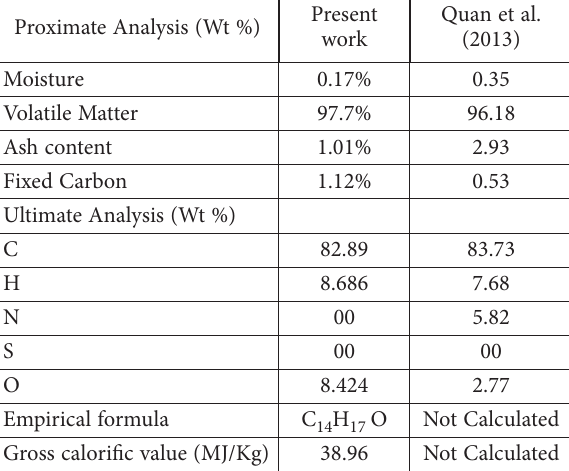
Table 1. Proximate and ultimate analysis of keyboard plastic waste sample alongwith available literature on the